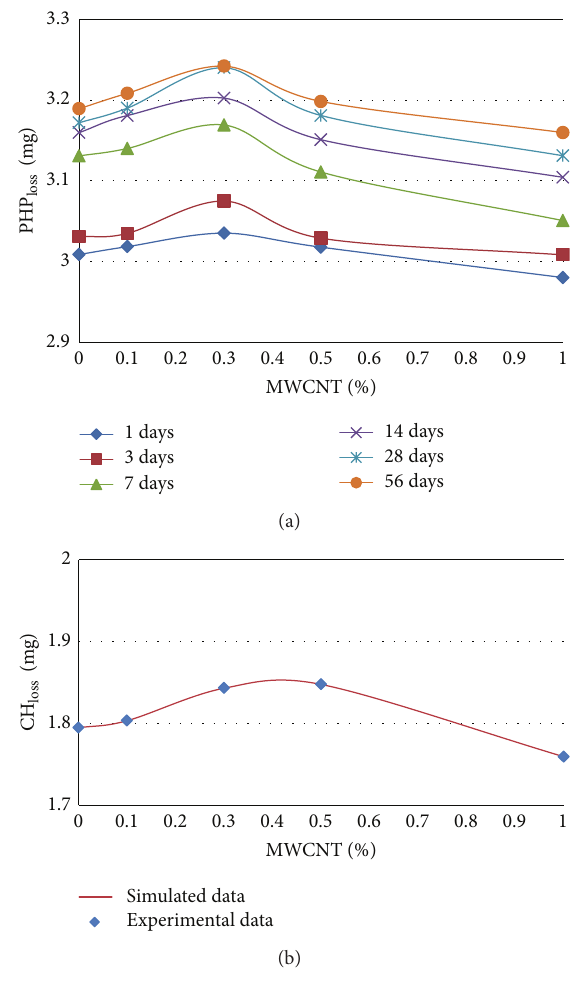
Figure 3: TGA results over time for paste cement with MWCNT at w/cm = 0.4, the calculated PHP loss (a) and CH loss (b) over time due to the evolution of hydration for different cement paste samples containing different percentages (0.1, 0.3, 0.5, and 1.0 wt%) of MWCNTs in comparison with control samples containing no MWCNT with w/cm =